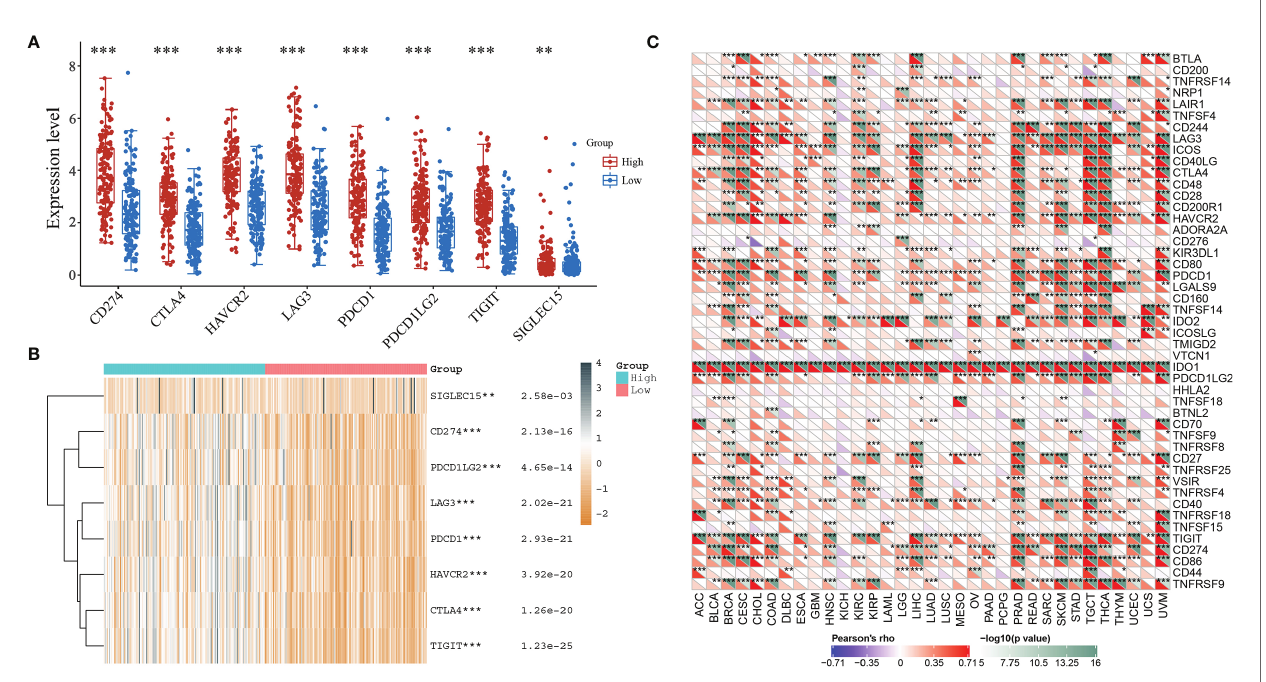
FIGURE 6 | Correlation between IDO1 expression level and immune checkpoint-associated gene expression. [ (A) Immune checkpoint-associated gene expression level in high and low expression level of IDO1 samples; (B) Heat map of immune checkpoint-associated gene expression; (C) Immune checkpoint-associated gene expression level in multiple cancers; *P < 0.05, **P < 0.01, ***P <